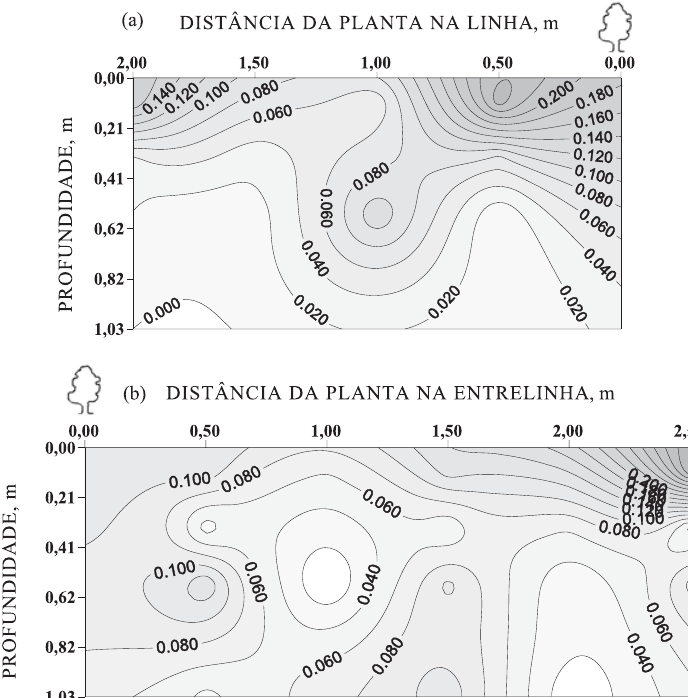
Figura 5. Distribuição espacial da densidade total de raízes da laranjeira ‘Hamlin’ enxertada em limoeiro ‘Cravo”, em cm de raízes por cm -3 de solo, no perfil de um Argissolo Amarelo (PAx) coeso, em uma toposseqüência de solos de tabuleiro localizada em Sapeaçu (BA), (a) na linha e (b) na